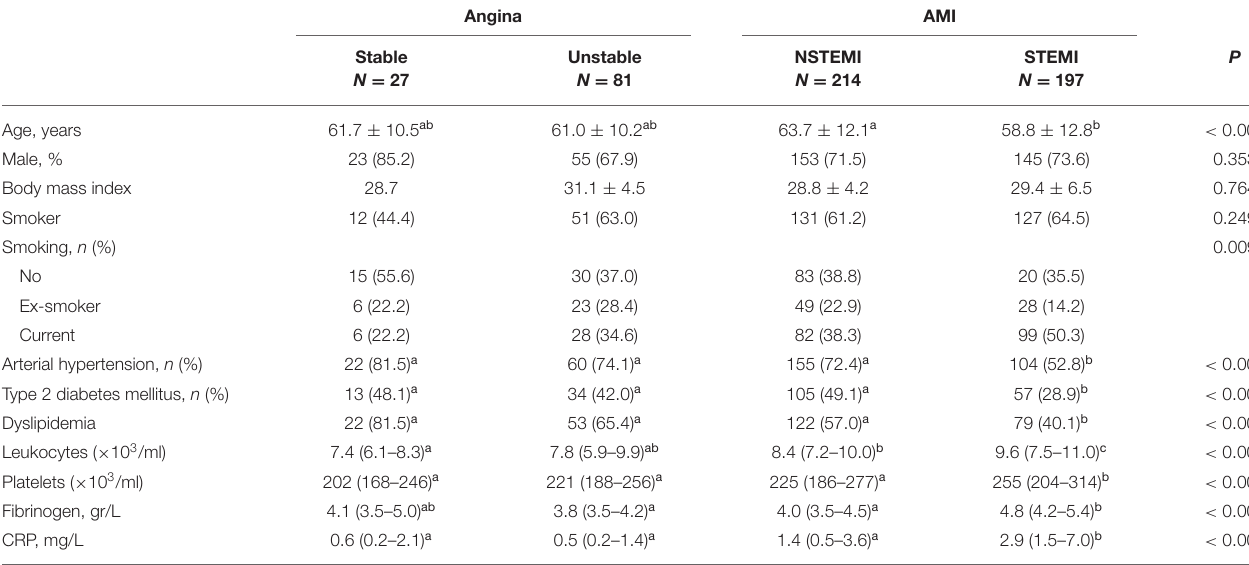
TABLE 2 | Characteristics of patients according to the type of event.